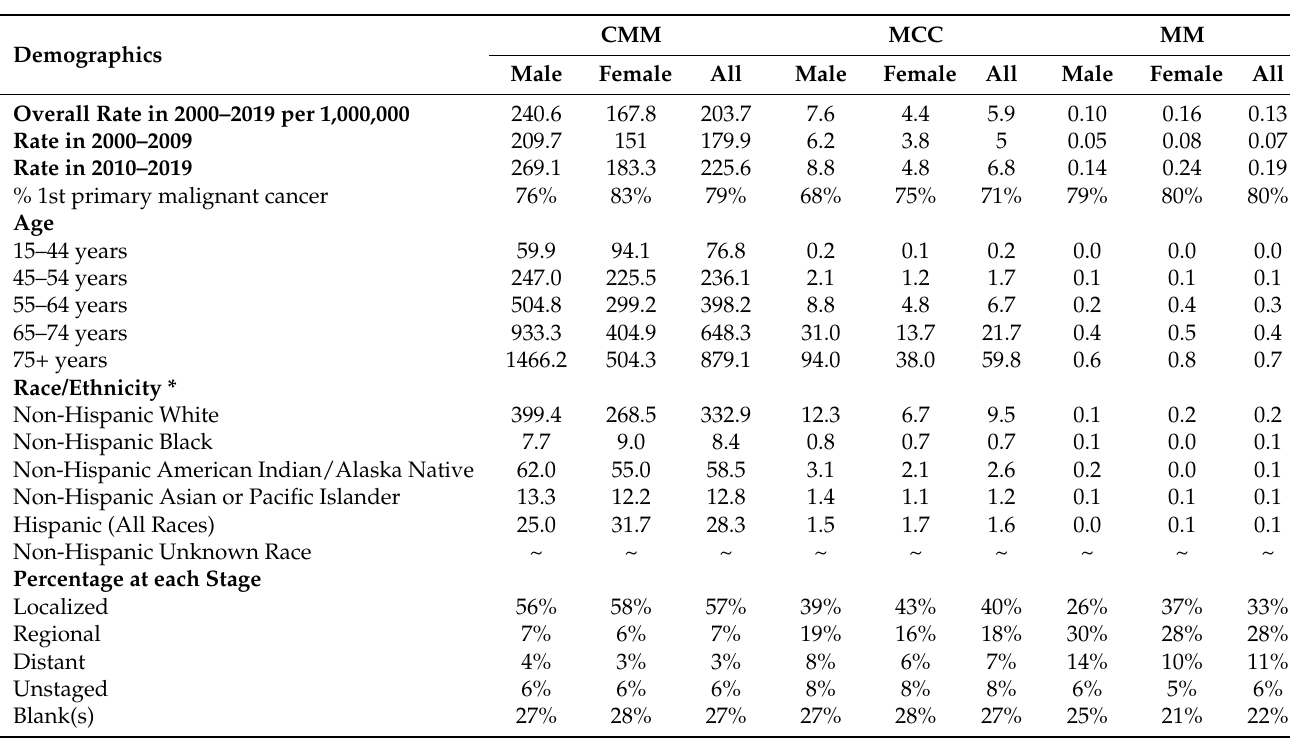
Table 3. Demographics and rates * of cutaneous malignant melanoma (CMM), Merkel cell carcinoma (MCC) and mucosal melanoma (MM) in 22 cancer registries in SEER